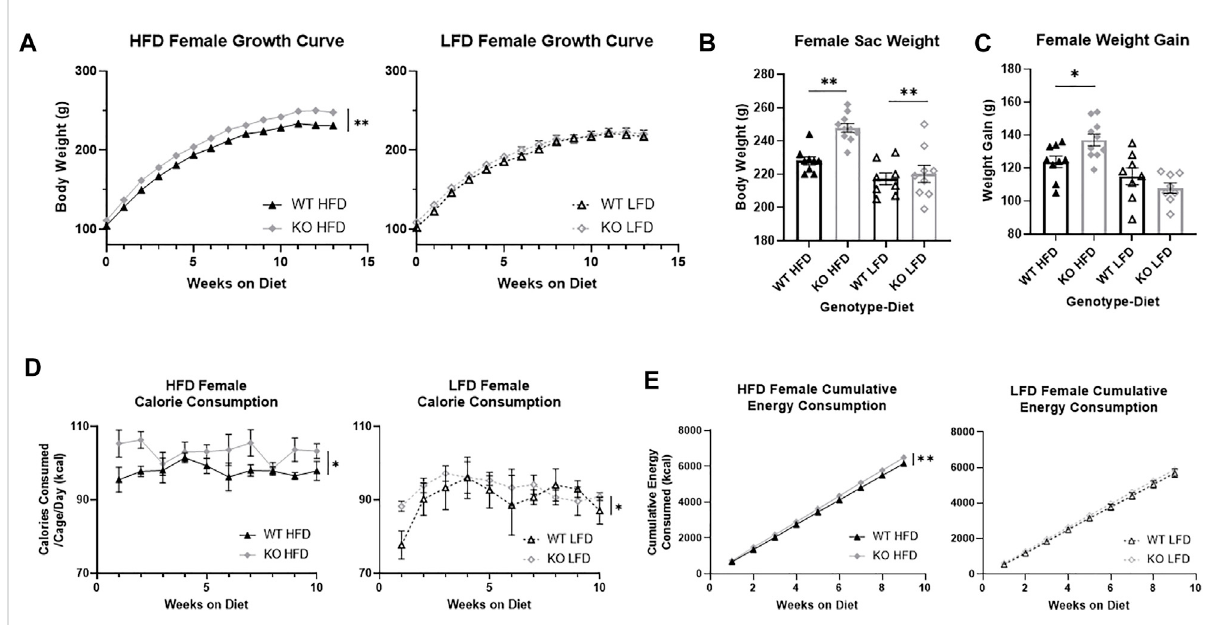
FIGURE 4 Body weight growth and energy consumption in female wild-type (WT; black triangle) and Krtcap3 knock-out (KO; gray diamond) rats. Rats were weighed weekly throughout the study, and fi nal weight and overall weight gain were recorded. Calorie consumption was recorded for the fi rst 10 weeks on diet, and cumulative energy consumption calculated for the fi rst 9 weeks on diet. To highlight genotype-driven differences, fi gures are separated by diet, high-fat diet (HFD; fi lled) and low-fat diet (LFD; empty). (A) In females, there was a three-way interaction between genotype, diet, andtime. Whendata wereanalyzed separately bydietcondition, KO femaleson aHFDweighedmore than WT counterparts, withno difference in weight between WT and KO LFD females. ** p < 0.01 for the effect of genotype over time in the HFD condition. (B) At euthanasia, KO females of bothdietshadahigherbodyweightthanWTfemales,withnointeractionbetweengenotypeanddiet.** p < 0.01representsmaineffectofgenotype. (C) Therewas an interaction betweengenotypeand diet for weight gain, where KO HFD females gained more weightthan WT HFD females, with no differencesinLFDfemales.* p < 0.05representstheeffectofgenotypeintheHFDcondition. (D) KOfemalesconsumedmorecaloriesovertimethan WTfemales,where* p < 0.05representsamaineffectofgenotypeovertimeacrossbothdiets. (E) KOHFDfemaleshadagreaterrateofcaloricintake than WT HFD females, but there were no differences by genotype in LFD females. ** p < 0.01 represents a signi fi cant difference in the slopes of the lines. Diet effects are reported in the “ Results ”